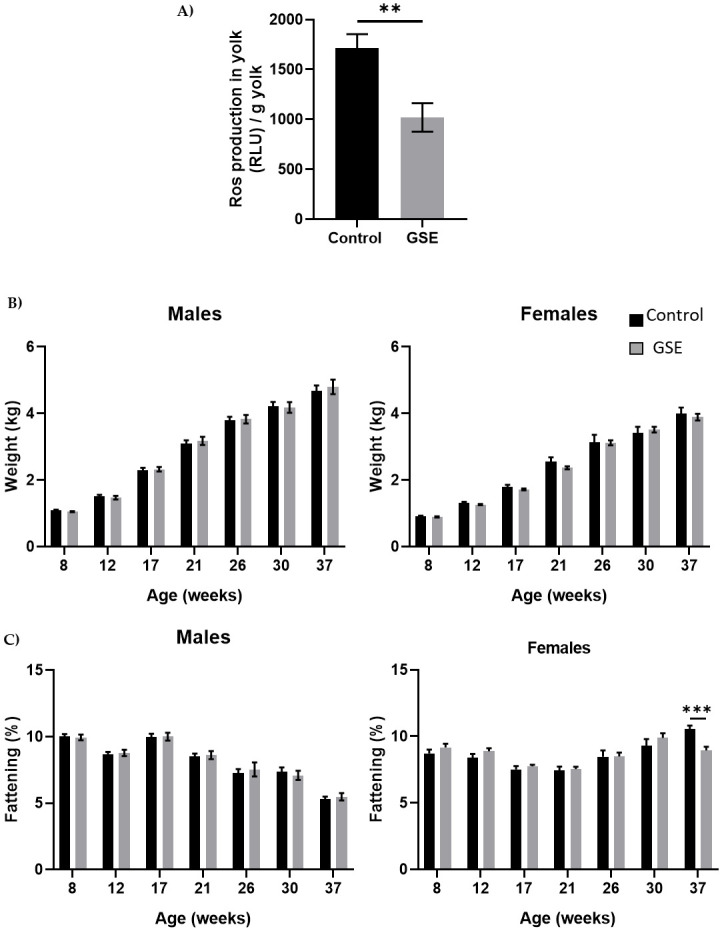
Growth curve.(A) Level of Reactive Oxygen Species (ROS, H202) in egg yolk of broiler hens fed 1% GSE dietary supplementation (n = 10 egg yolks analysed per group). Results are expressed in Relative Luminescent Units per gram of yolk. (B) Live body weight of males (left panel) and females (right panel) from 8 to 37 weeks of age (n = 20). Animals were weighed every 4 weeks. (C) Fattening level in male (left panel) and female (right panel) broilers was assessed by CT scan from 8 to 37 weeks of age (n = 10 animals/sex). Results are presented as means ± SEM. P values were considered significant if **, p < 0.01. ***, p < 0.001.